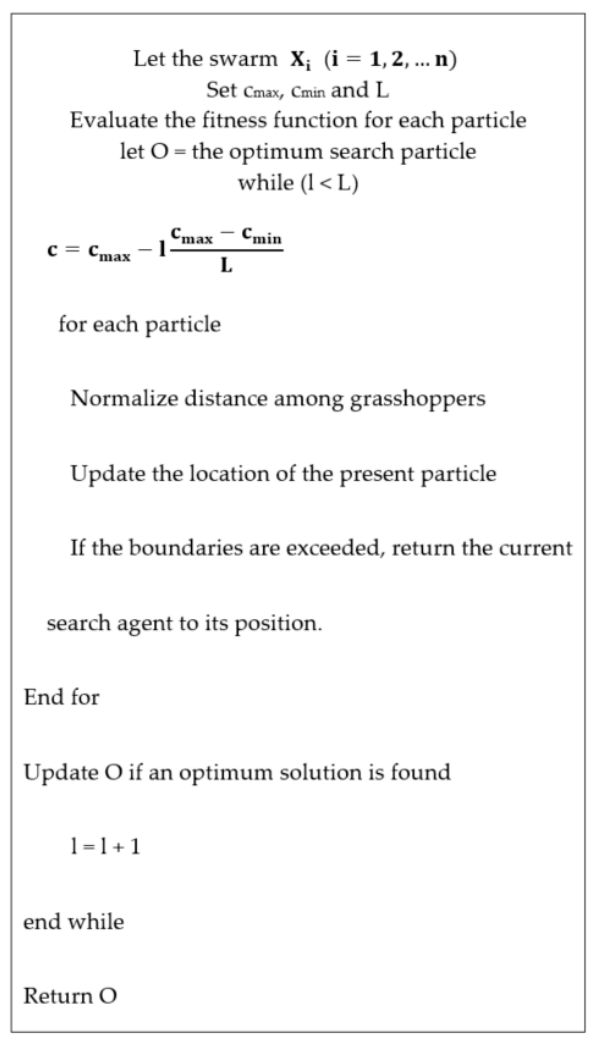
Figure 2. Pseudo code of the Grasshopper Optimization Algorithm (GOA).